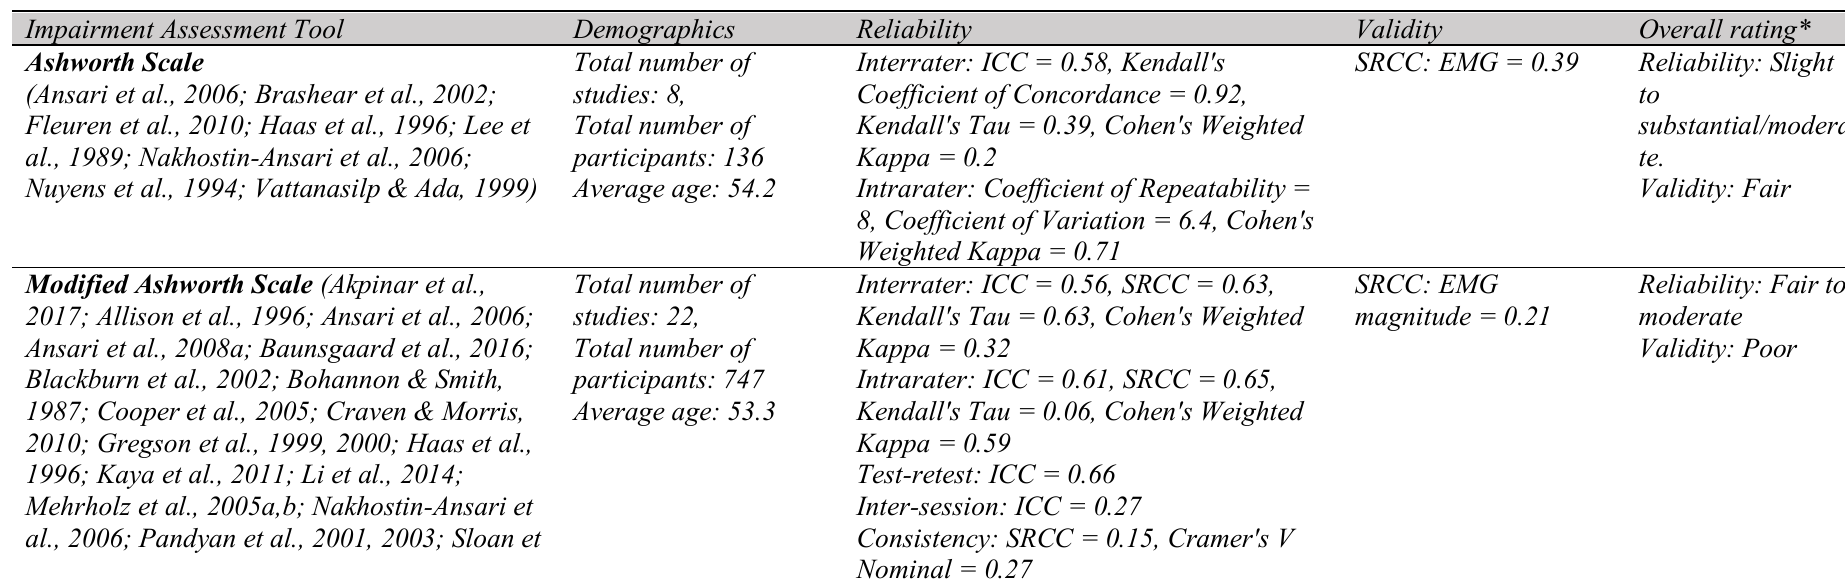
Table 4. Reliability and validity of included impairment assessment